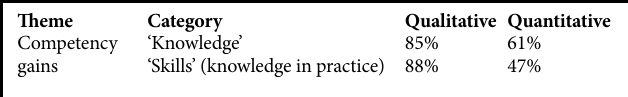
table III. corroboration of results re knowledge gains